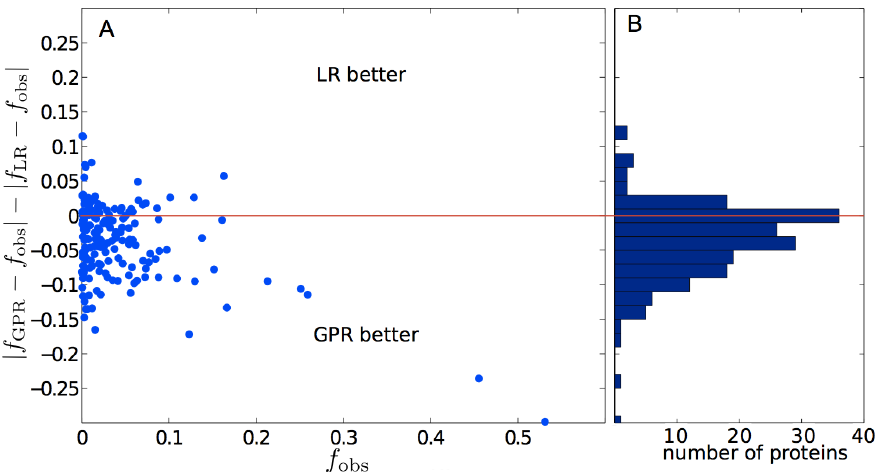
Figure 3. Difference between the observed and the modeled propensity values f . A: Points in the upper half of the graph correspond to the cases in which LR performs better than GPR, and vice versa for the lower half. B: The histogram summarizes the overall performance of LR and GPR.